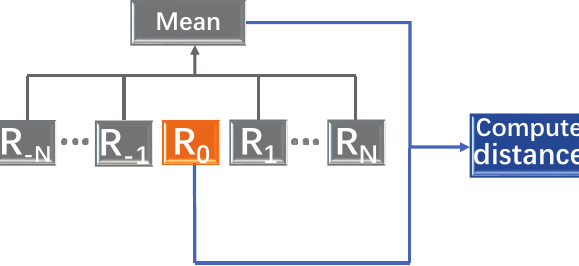
Figure 1. The difference of means